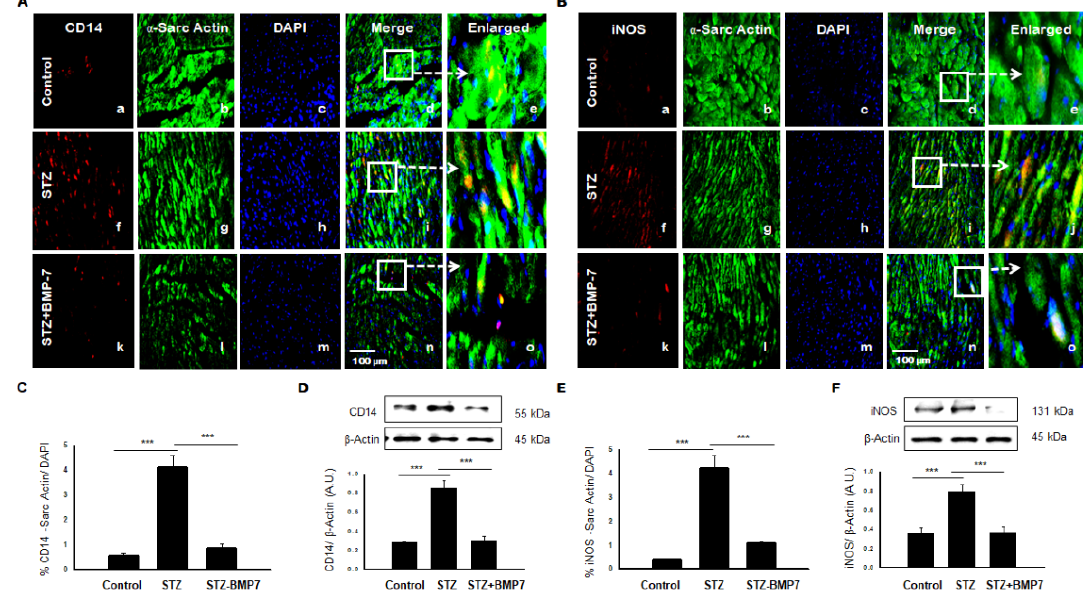
Figure 5. BMP-7 decreases expression of infiltrated monocyte (CD14) and macrophage M1 (iNOS) markers in the diabetic heart. ( A , B ) Representative photomicrographs of heart sections stained in the control group (a–e), STZ group (f–j) and STZ-BMP7 group (k–o) with sarcomeric- α actin (green, stained cardiac myocyte) (b, g, l) and CD14 ( A ) and iNOS ( B ) in red (a, f, k) with nuclei stained (c, h, m) by DAPI in blue, merged (d, i, n) and enlarged (e, j, o) image. ( C , E ) Quantitative analysis-derived histograms of CD14 ( C ) and iNOS ( E ) +ve cardiomyocytes (colocalization of both red and blue DAPI in green cardiomyocyte) quantified over total DAPI in heart sections of mice. ( D , F ) Representative Western blots and densitometric analysis of inflammasome CD14 ( D ) and iNOS ( F ) markers are shown. Quantities are presented as an arbitrary unit (A.U). Statistical analysis was performed using One-Way ANOVA, which was followed by the Tukey test. Error bars= mean ± S.E.M. * p < 0.05, ** p < 0.01, *** p < 0.001; Scale bar = 100 µm; n = 16/group.